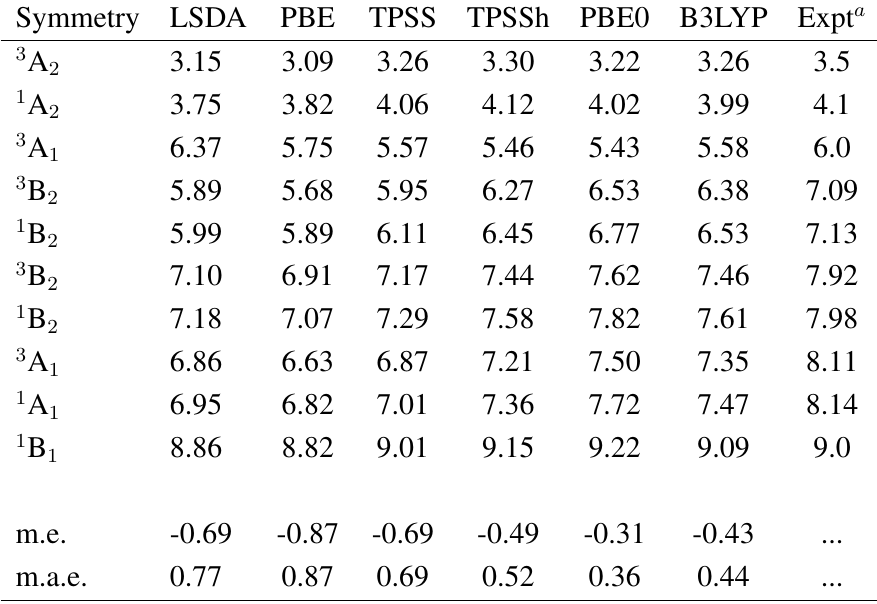
Table 5. The same as Table 2, but for formaldehyde (H is 6.90 eV.